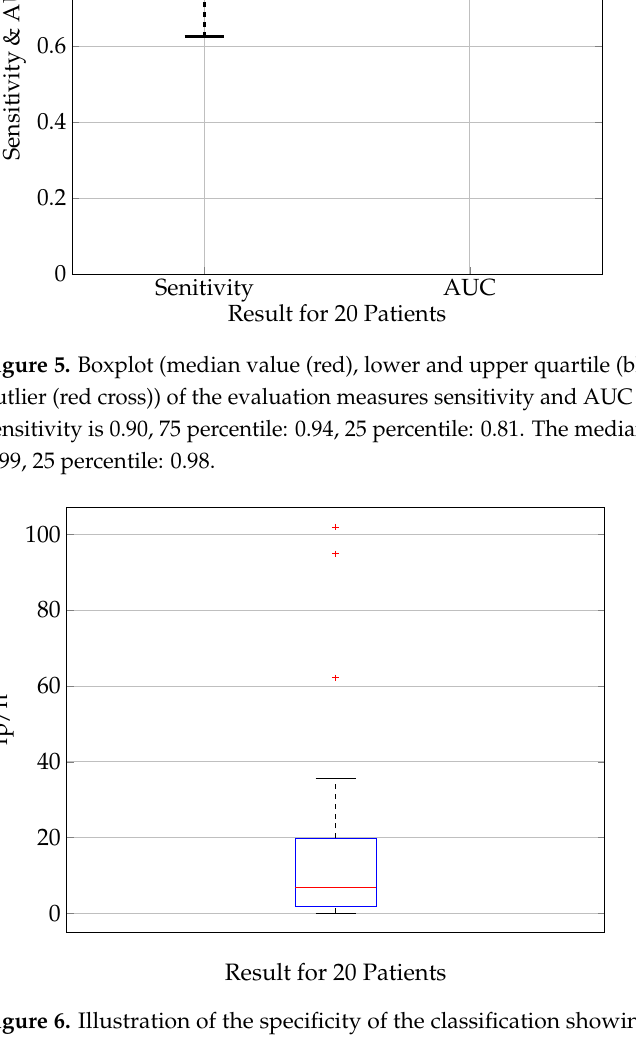
Figure 5. Boxplot (median value (red), lower and upper quartile (blue), min. and max. value (black), outlier (red cross)) of the evaluation measures sensitivity and AUC score for 20 patients. The median sensitivity is 0.90, 75 percentile: 0.94, 25 percentile: 0.81. The median AUC score is 0.98, 75 percentile: 0.99, 25 percentile: 0.98.